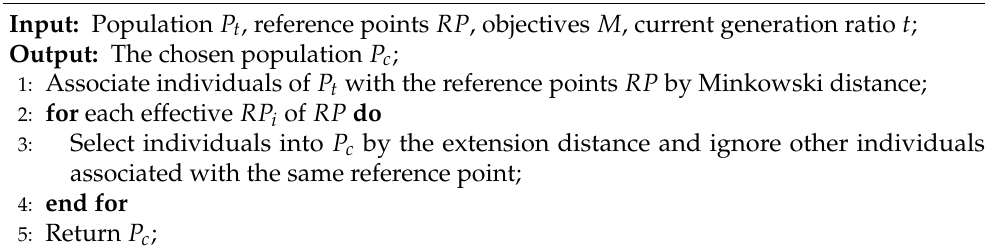
Algorithm 4 The procedure of handling irregular PFs.